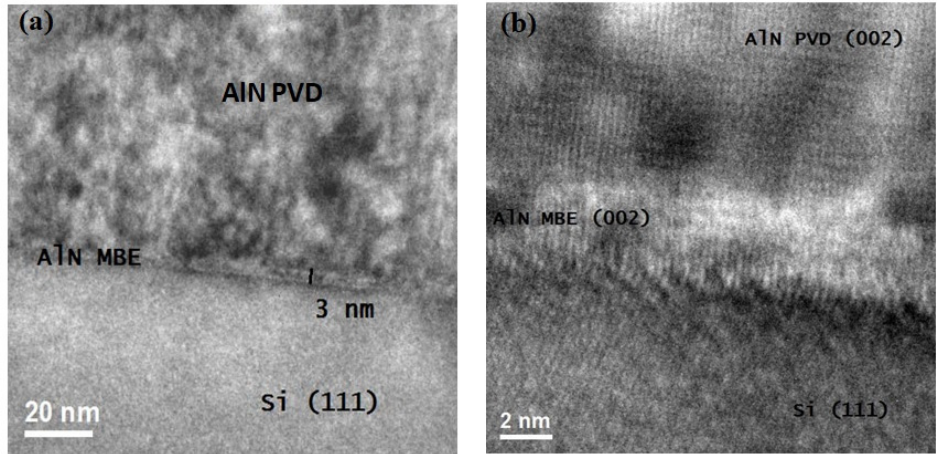
Figure 6. ( a ) TEM Cross-section image of AlN deposited by DCMS on AlN MBE/Si(111); ( b ) HRTEM image of AlNDCMS/AlNMBE/Si(111) interfaces.